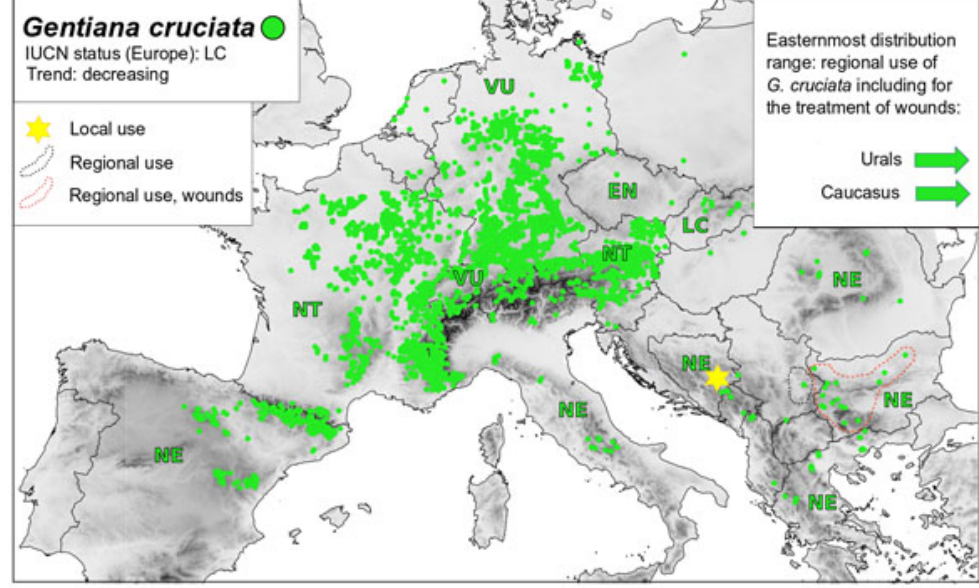
Figure 5. Map of distribution G. cruciata— conservation status and medicinal use, Legend: IUCN status—Least Concern (LC); Near Threatened (NT); Vulnerable (VU); Endangered (EN); Critically Endangered (CR); and Not Evaluated (NE).